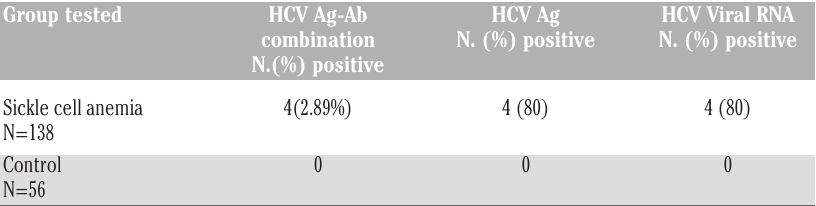
Table 2. Pattern of reactivity sickle cell disease patients with HCV antigen, antibody and viral RNA. Group